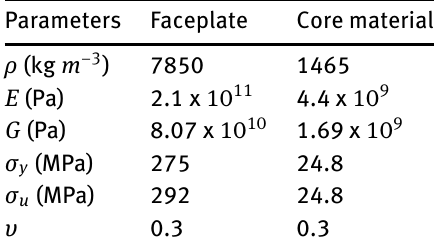
Table 2: Material constants of faceplates and core sandwich